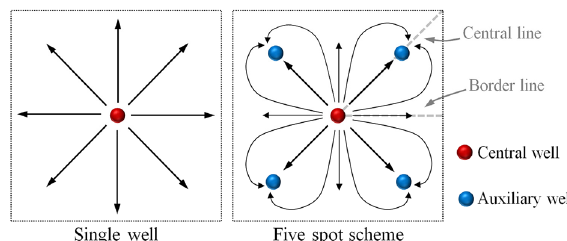
Fig. 4 Flow lines for single well and five‑spot